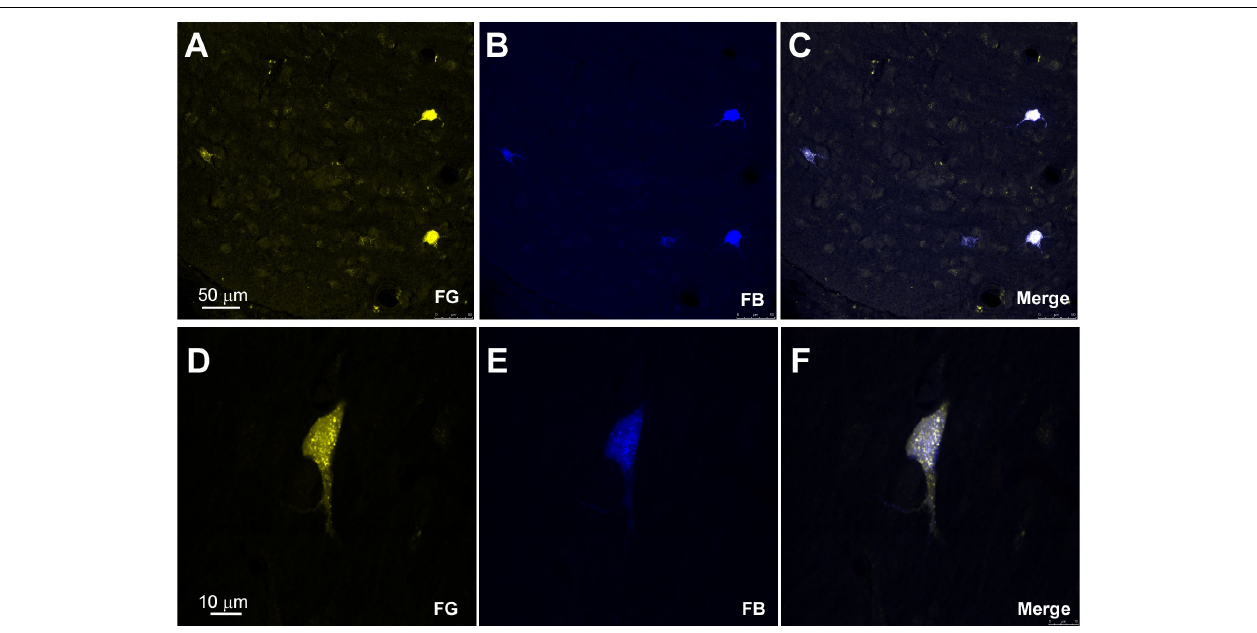
FIGURE 3 | Microphotographs of HDB labeled neurons after injections/deposits in S1/V1. (A–C) Confocal images showing single and double-labeled neurons in HDB in a representative animal; the merge shows the presence of double-labeled neurons. (D–F) Another examples of double-labeled neurons at high magnification.